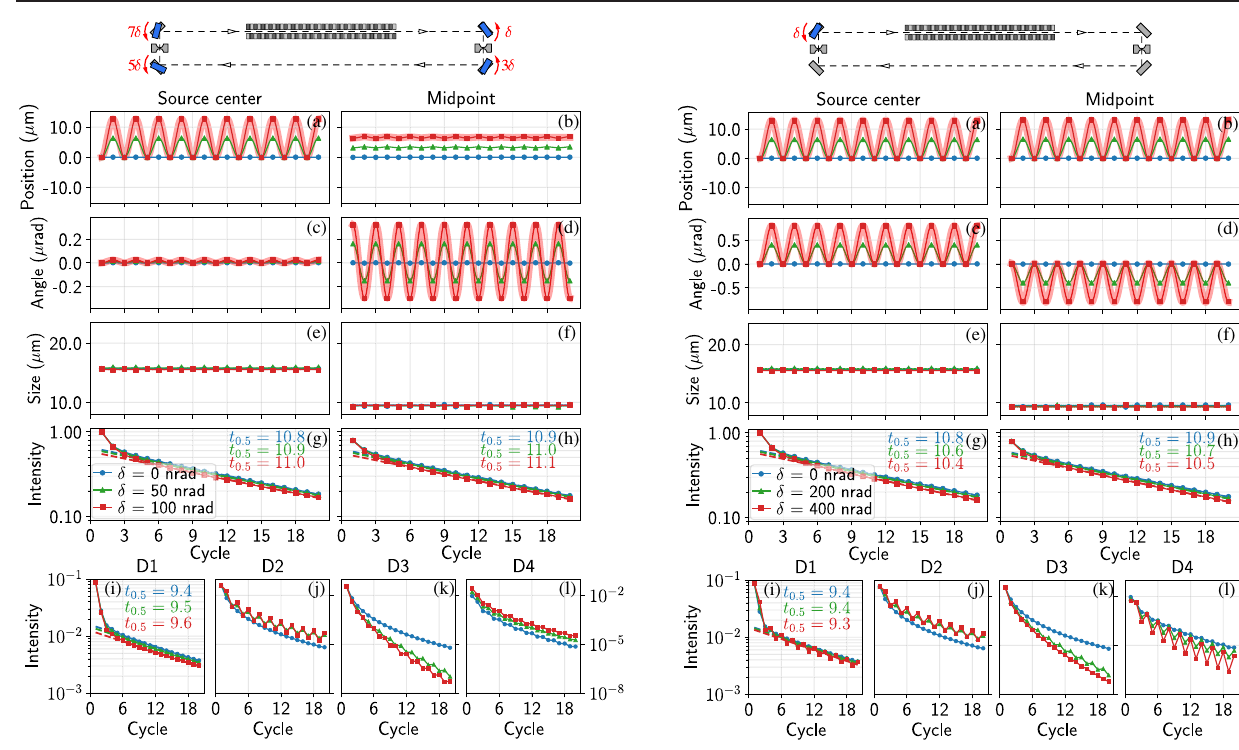
FIG. 21. Numerical simulation results of x-ray beam dynamics in the confocal rectangular four-crystal cavity with systematically misaligned crystal yaw angles.